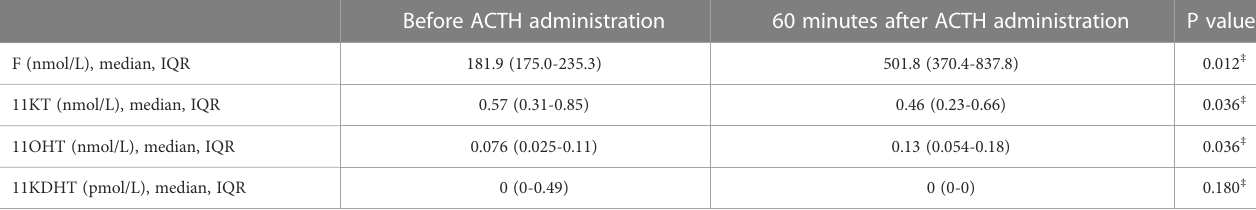
TABLE 5 Steroid hormone values before and at 60 minutes after ACTH administration (Study